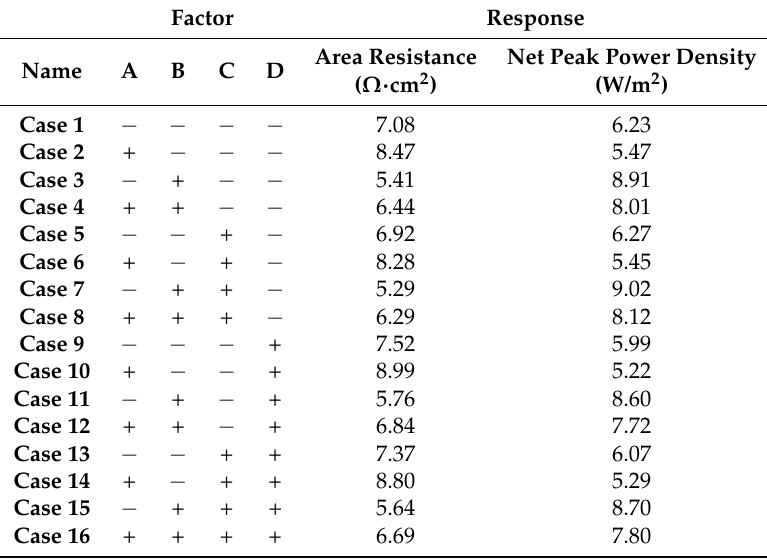
Table 6. Summary of factors, area resistance of the dilute solution compartment, and net peak power densities of the unit cell in the 2D model of a triangular corrugated channel: A, velocity; B, temperature; C, corrugation density; D, corrugation height. Case 1 is the base